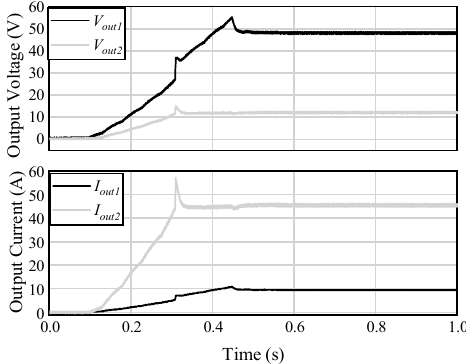
Figure 7. Dual port output waveforms.